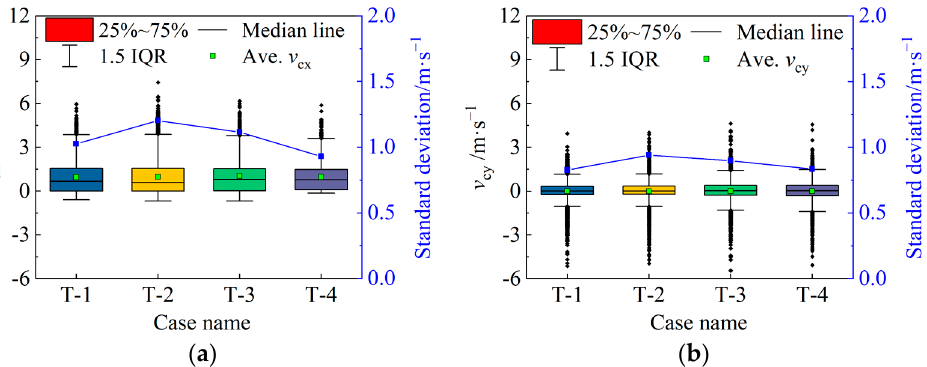
Figure 15. Analytical results of ( a ) cutter horizontal velocity signals and ( b ) cutter vertical velocity signals.